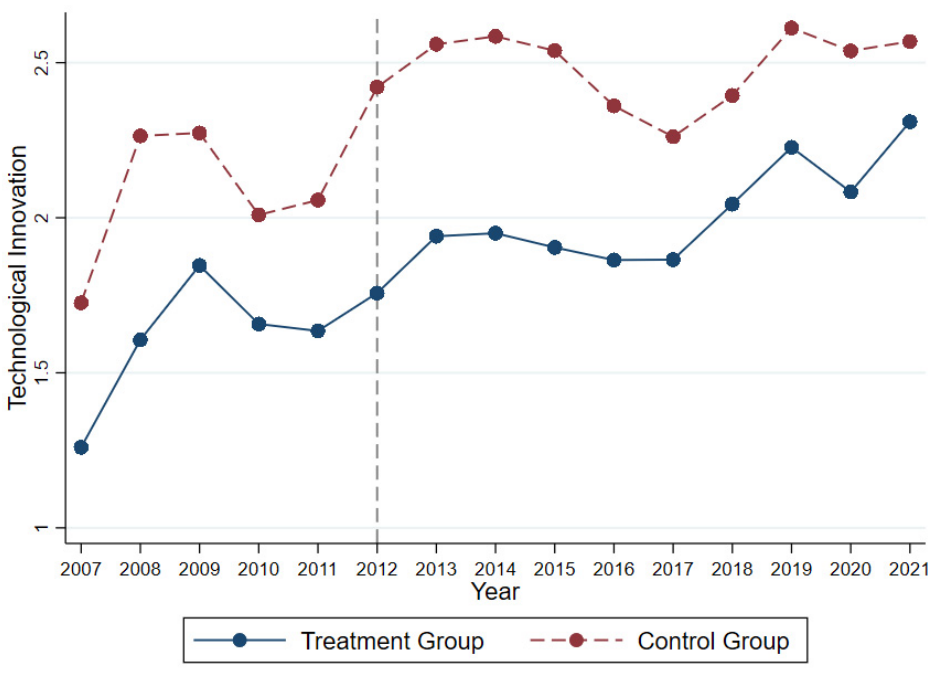
Figure 1. Trend of technological innovation over time.